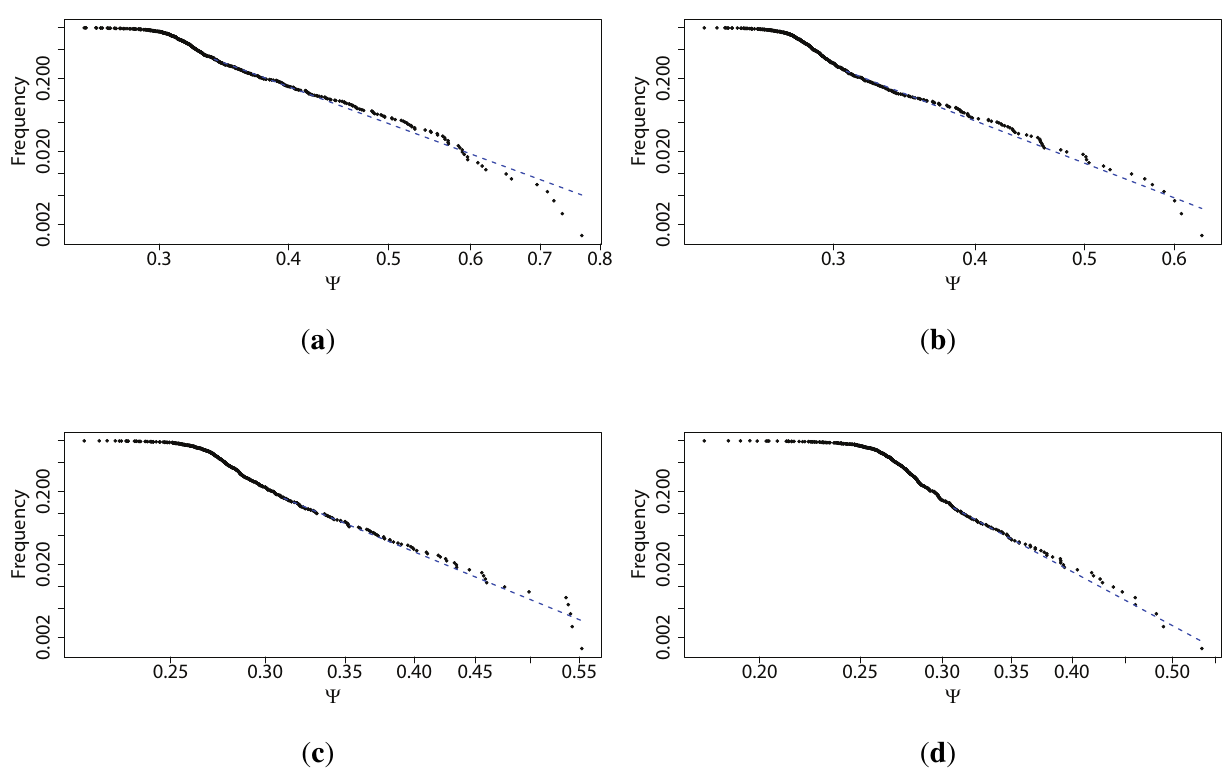
Figure 2. Power law distributions (on a log-log scale) fitted for the percentage of times the Maximum Entropy Production Principle correctly guesses the quantile of the next price change ( Ψ ) based on transaction level logarithmic price change history for 707 stocks from Warsaw Stock Exchange sampled every (cid:28) price changes, discretized into four quantiles, for different values of (cid:28) : (a) (cid:28) = 1 ; (b) (cid:28) = 5 ; (c) (cid:28) = 10 ; (d) (cid:28) = 20 . We observe that in general, the scaling parameter of the power law fitted to the tails of the distributions of Ψ increases with the time scale (cid:28) , that is, the predictability decays faster for larger values of (cid:28) , which is consistent with our other findings.